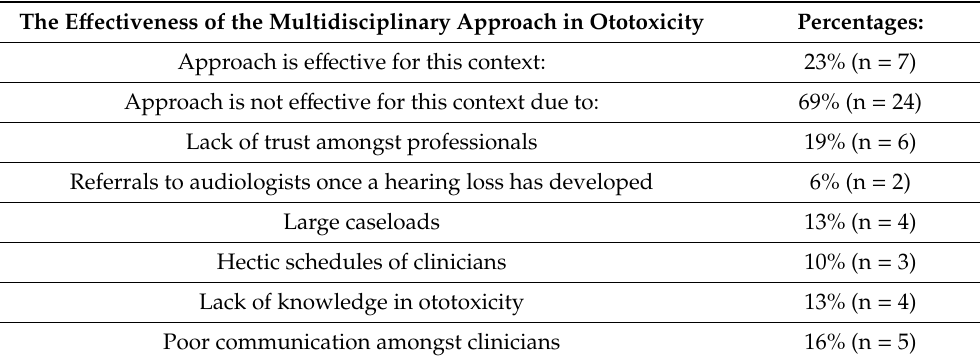
Table 2. The e ff ectiveness of the multidisciplinary approach in South